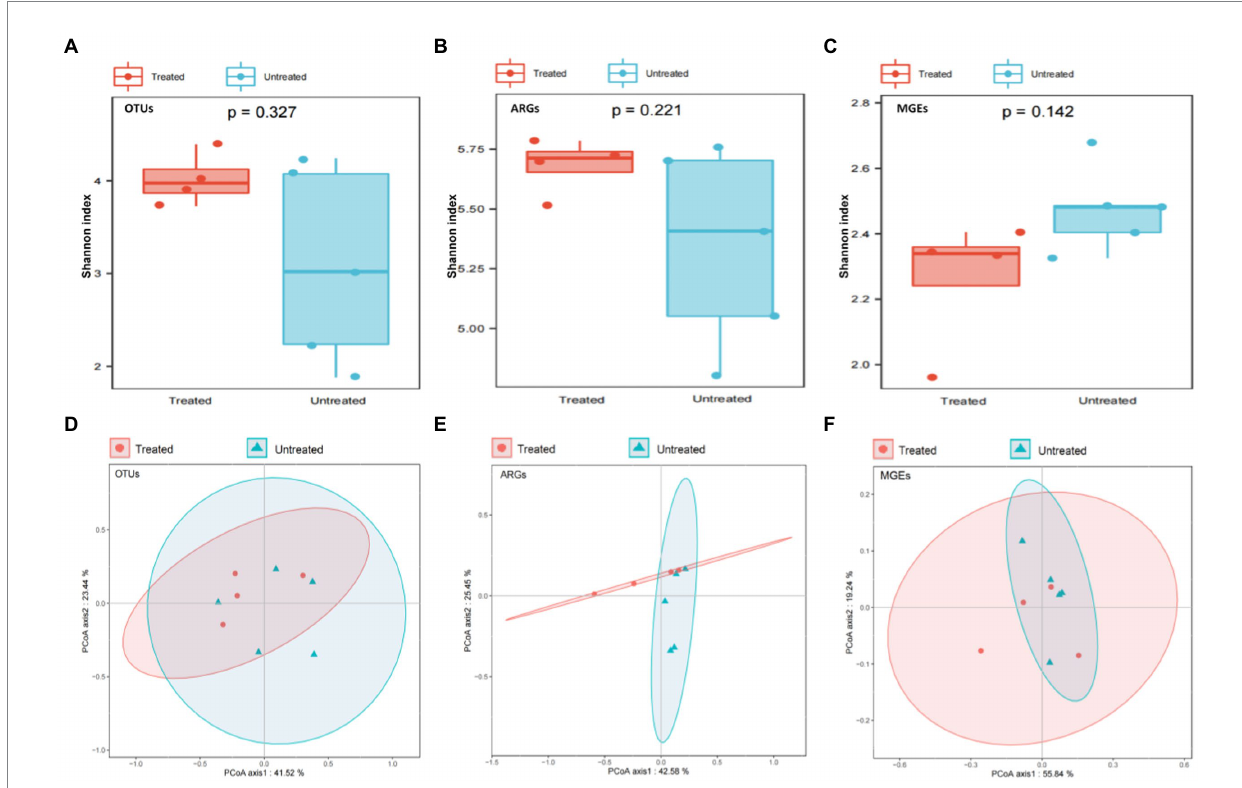
FIGURE 1 Comparison of diversities among OTUs, ARGs and MGEs in the untreated and treated dental waste waters. (A) alpha-diversity of OTUs; (B) alpha- diversity of ARGs; (C) alpha-diversity of MGEs; (D) Beta diversity of OTUs; (E) Beta diversity of ARGS; (F) Beta diversity of MGEs.